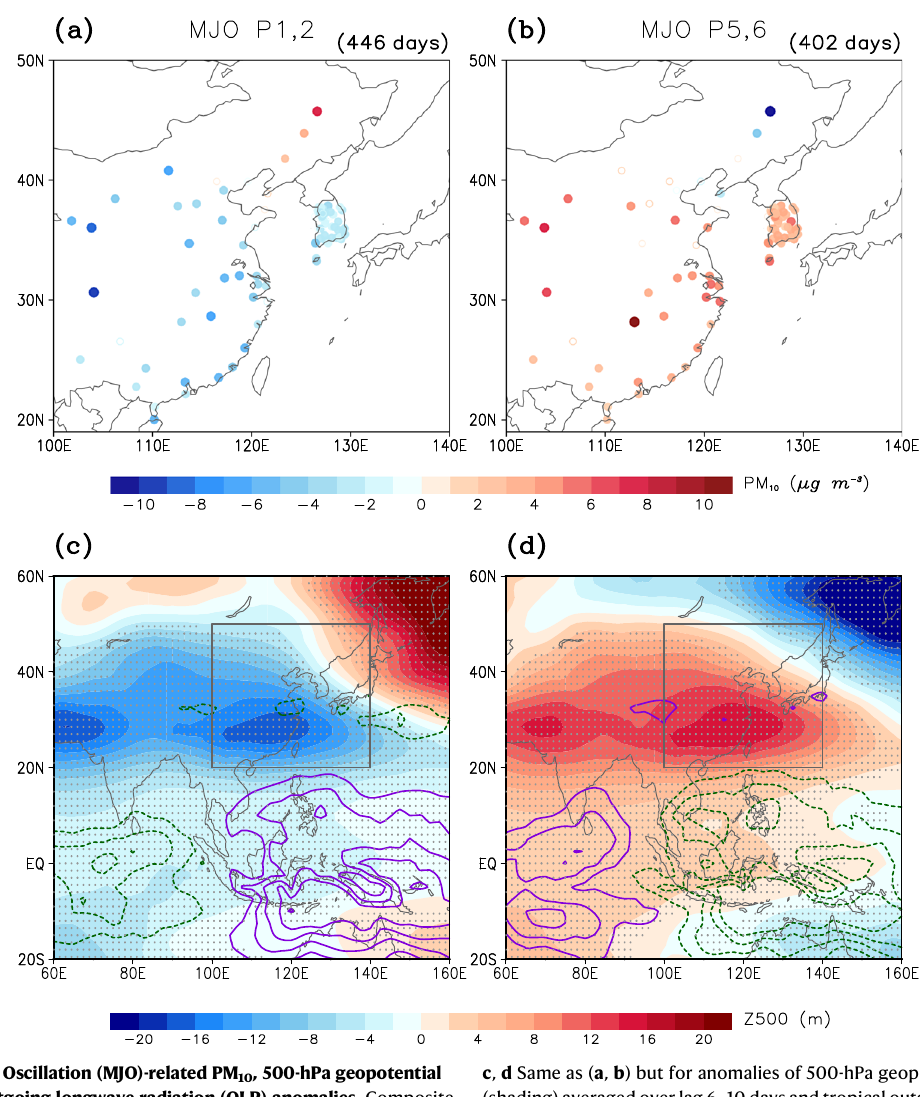
Fig. 2 | Madden – Julian Oscillation (MJO)-related PM 10 , 500-hPa geopotential height (Z500), and outgoing longwave radiation (OLR) anomalies. Composite PM 10 anomalies averaged over lag 6 – 10days during Madden – Julian Oscillation (MJO) phases ( a ) 1 – 2 and ( b ) 5 – 6. Multiple counts of the same day are not allowed. Sample size is denoted at the top-right corner, and values that are statisticallysigni fi cantatthe95%con fi dencelevelaredenotedwith fi lledcircles.